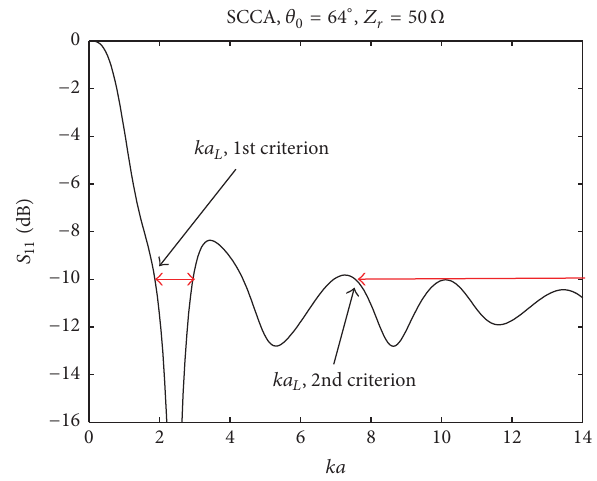
Figure 4: Lowest operation 𝑘𝑎 𝐿 definition criteria.